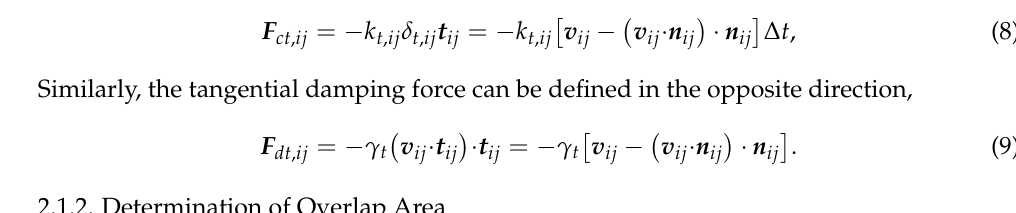
Figure 2. ( a ) Relative velocity v ij in the action point p c ; ( b ) Resolution of the relative